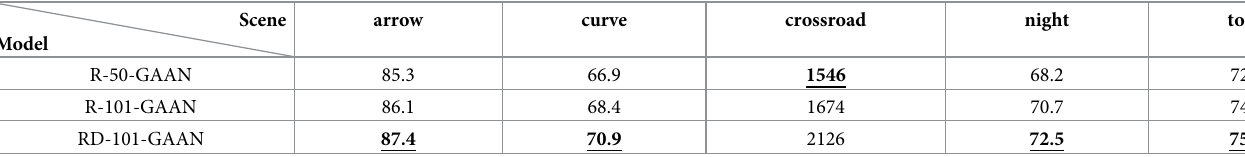
Table 7. Ablation experiments of GAAN with different backbone.